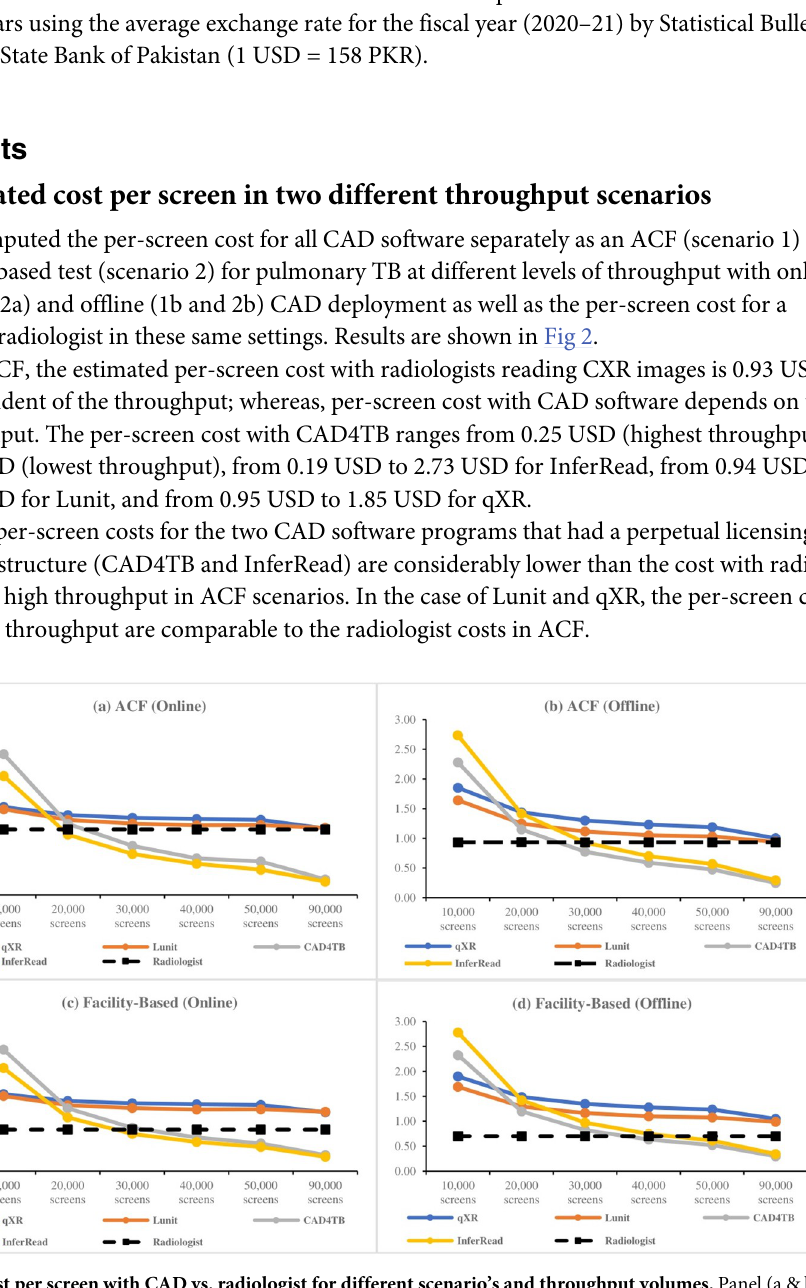
Fig 2. Cost per screen with CAD vs. radiologist for different scenario’s and throughput volumes. Panel (a & b) represents per screen cost with CAD software and radiologist online and offline deployment in ACF implementation strategy and in facility-based triage testing are shown in panel (c